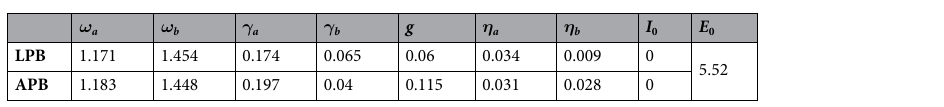
Table 1. Extracted fitting parameters for Fano resonance excited by LPB and